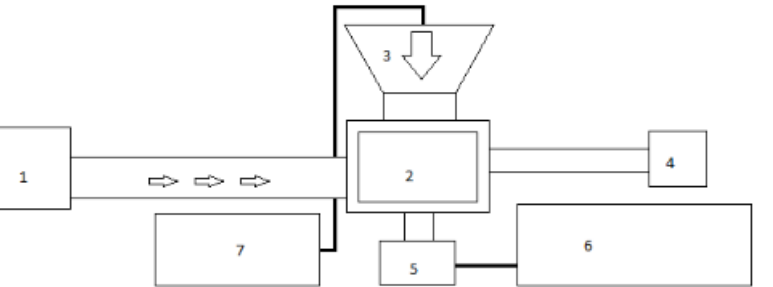
Figure 2. The scheme of the hybrid dryer: (1) air heater and fan, (2) dryer chamber, (3) ultrasound transducer, (4) microwave generator, (5) balance, (6) control system (PC), and (7) ultrasound gener- ator.